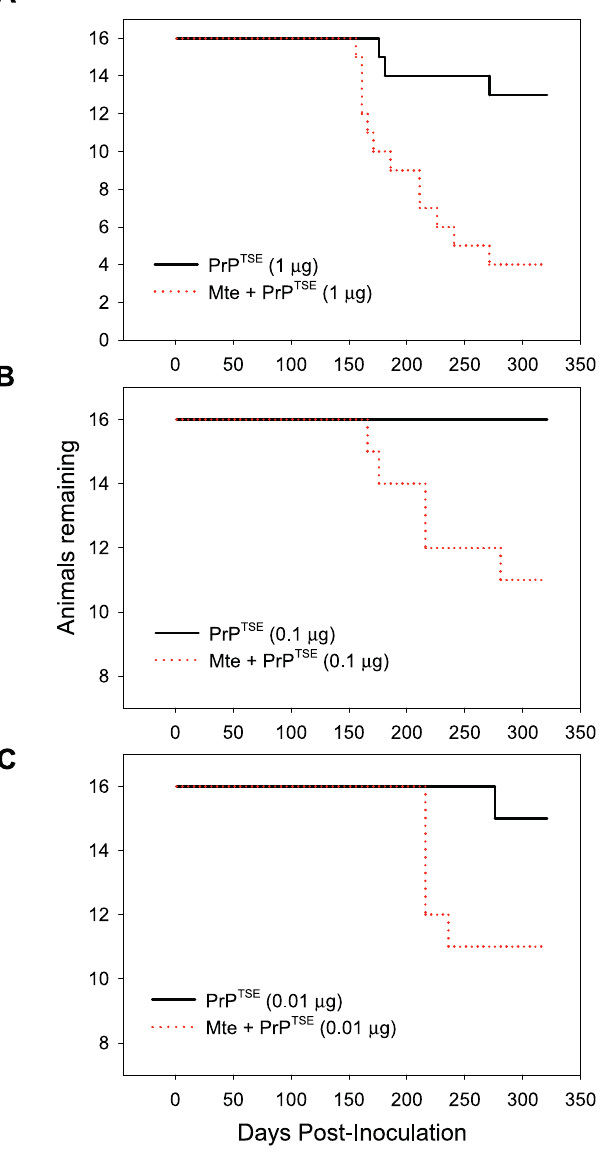
Figure 3. Concurrent Peroral Administration of Mte and PrP TSE Dramatically Increases Disease Penetrance at Agent Doses That Typically Fail to Produce Clinical Symptoms (PrP TSE –Mte Mixture) (A) Mte increases disease penetrance and shortens incubation periods associated with ingestion of 1 l g of purified PrP TSE . Concurrent peroral dosage of lower, typically subclinical doses of purified PrP TSE (0.1 or 0.01 l g, [B and C]) with Mte increases disease incidence. Animals dosed with Mte alone remained healthy throughout the course of the experiment (unpublished data).